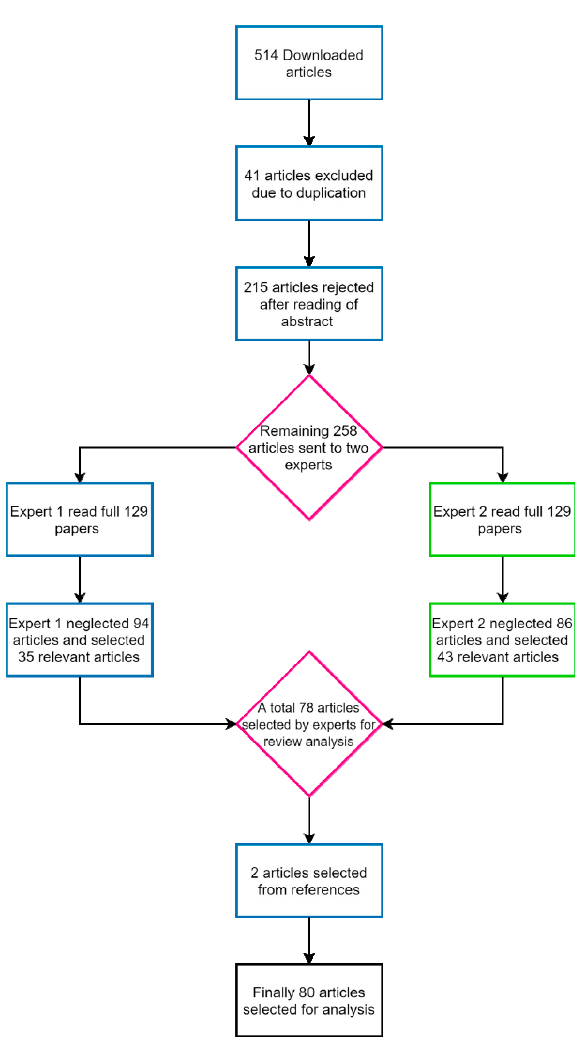
Figure 2. Flow diagram regarding the inclusion and exclusion of studies in this review.